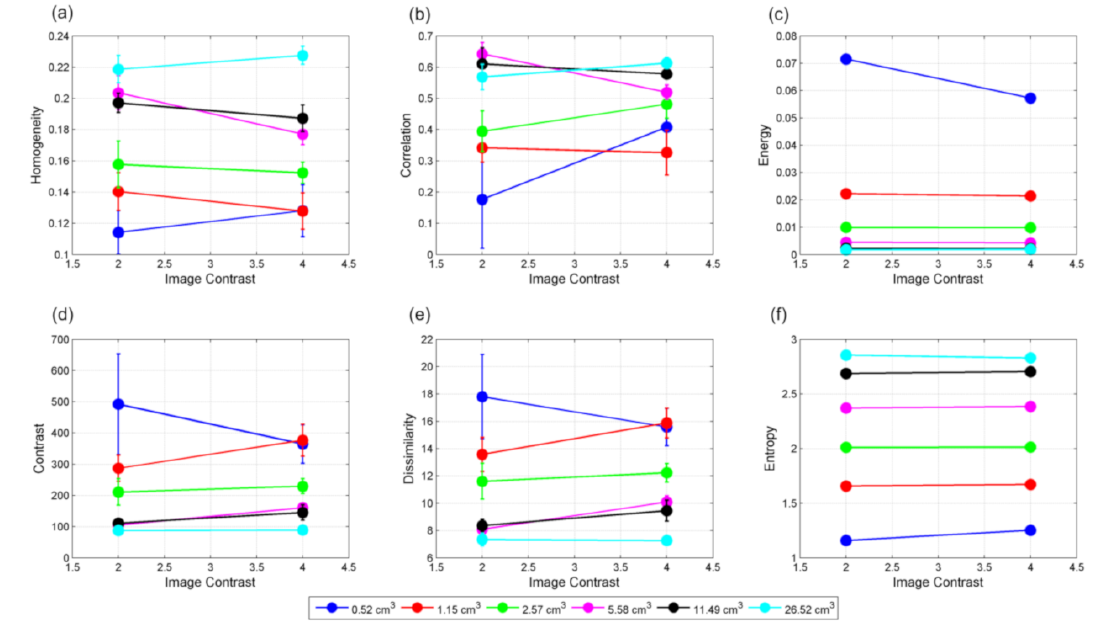
Figure 6. Six textural features vs. image contrast for VOI true for acquisition duration 900 s and quantization level 64. ( a ) Homogeneity, ( b ) contrast, ( c ) energy, ( d ) contrast, ( e ) dissimilarity and ( f )